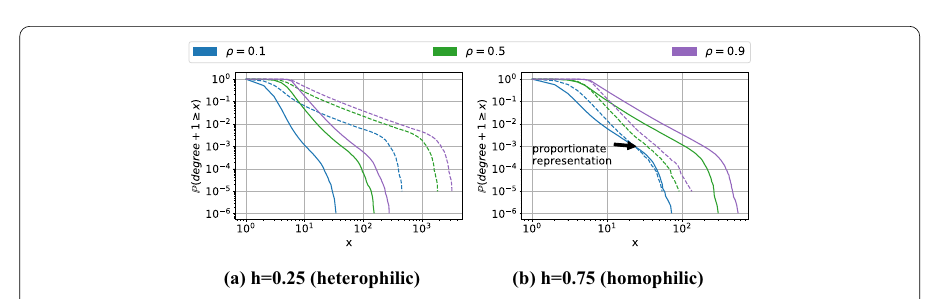
Fig. 8 Complementary cumulative distribution by class for synthetic networks and majority associated noise. The statistics for minority/majority are represented by dashed/solid lines respectively. Different colours correspond to different values of the retain parameter ρ . To increase clarity, standard deviations are not shown. For fixed ρ , comparatively higher values of the solid line indicate an over representation of the majority in degree rankings, equal values proportional representation. As expected the majority noise has a strong effect on the majority but also a minor effect on the minority. In heterophilic regimes the minority remains disproportionately represented for any ranking. In homophilic regimes for ρ = 0.1 we can have a ranking with proportionate representation if we consider rankings above the top 0.1% of